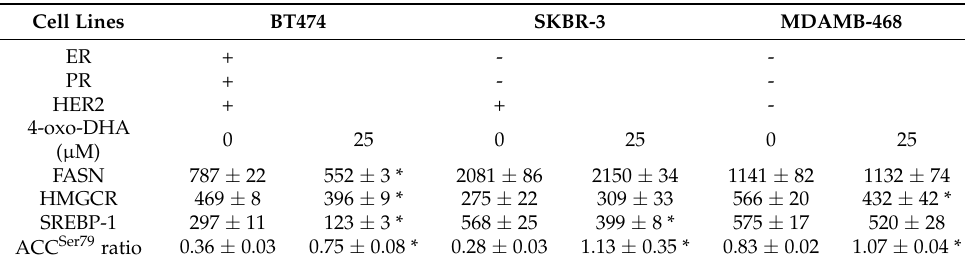
Table 4. Effect of 4-oxo-DHA on Lipid